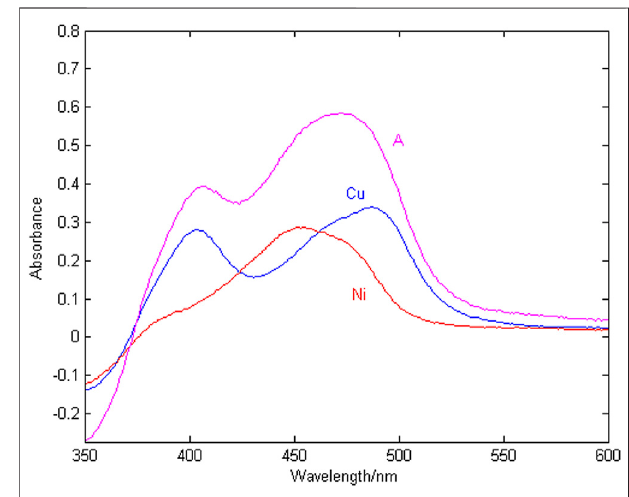
FIGURE 2 | Absorption spectra of Cu, Ni and their mixture